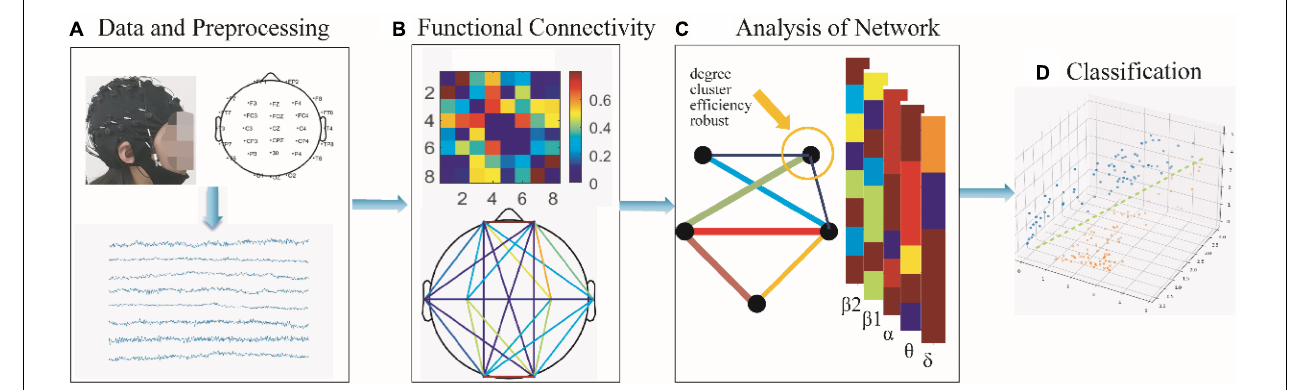
FIGURE 1 | The framework proposed in this paper. (A) Collection of SCZ as well as HC resting-state EEG for 2 min followed by pre-processing. (B) Construction of single-layer brain networks with δ (0.5–4 Hz), θ (4–8 Hz), α (8–13 Hz), β 1 (13–20 Hz), β 2 (20–30 Hz), and multilayer brain networks. (C) Statistical analysis of networks, including the degree, clustering coefficient, local efficiency, and connectivity robustness. (D) Using classifiers for accurate discrimination of psychiatric disorders to find potential biological markers of SCZ depending on the classification results.